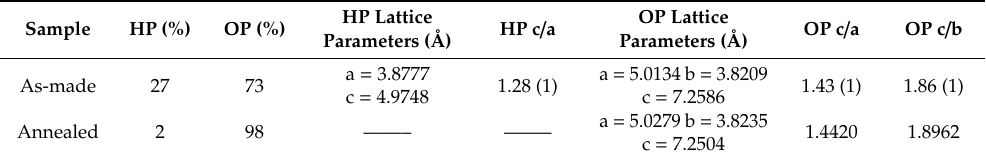
Figure 3. TEM studies on the annealed NPs. Figures ( a – d ) show the particles observed by the TEM, their size distribution, the HR-TEM and SAD images of the annealed NPs, respectively. Table 1. The volume fractions and lattice parameters of the hexagonal phase (HP) and orthorhombic phase (OP) in the as-made and annealed nanoparticles (NPs).